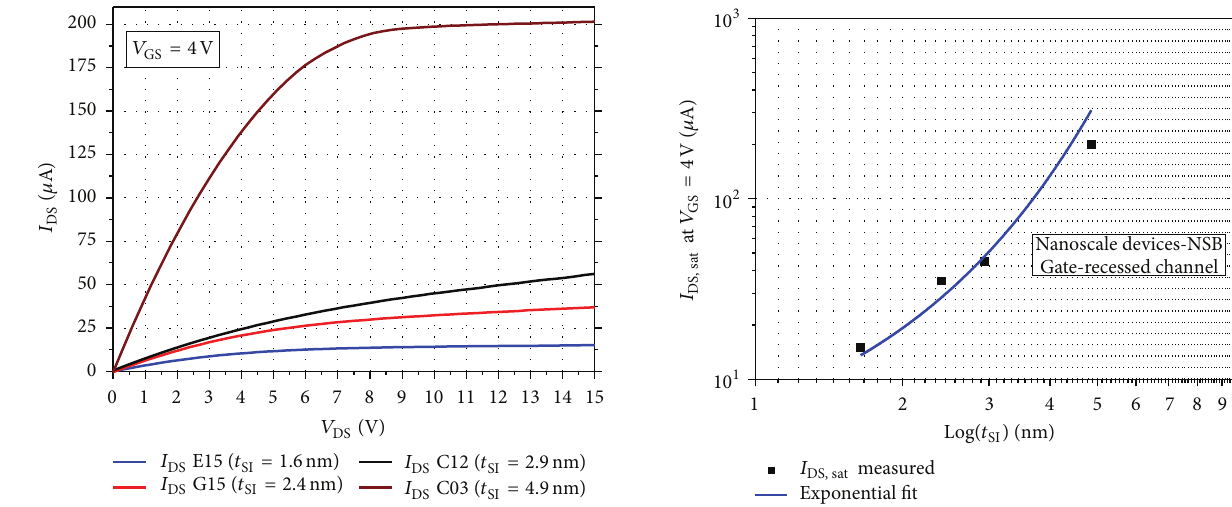
Figure 8: Measured 𝐼 - 𝑉 characteristics for NSB’s thickness for DS DS four NSB devices (dices E15, C12, G15, and C03) having a channel ) of 1.6, 2.4, 2.9, and 4.9 nm, respectively. thickness ( 𝑡 SI